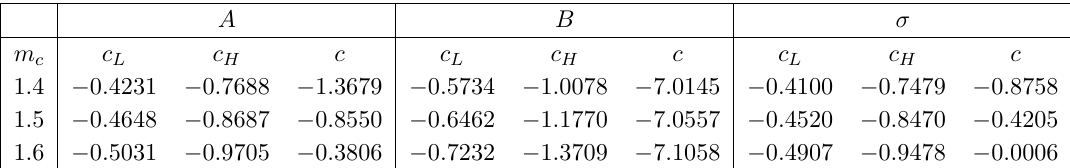
√ s = 10 . 6 GeV. The unit of m c